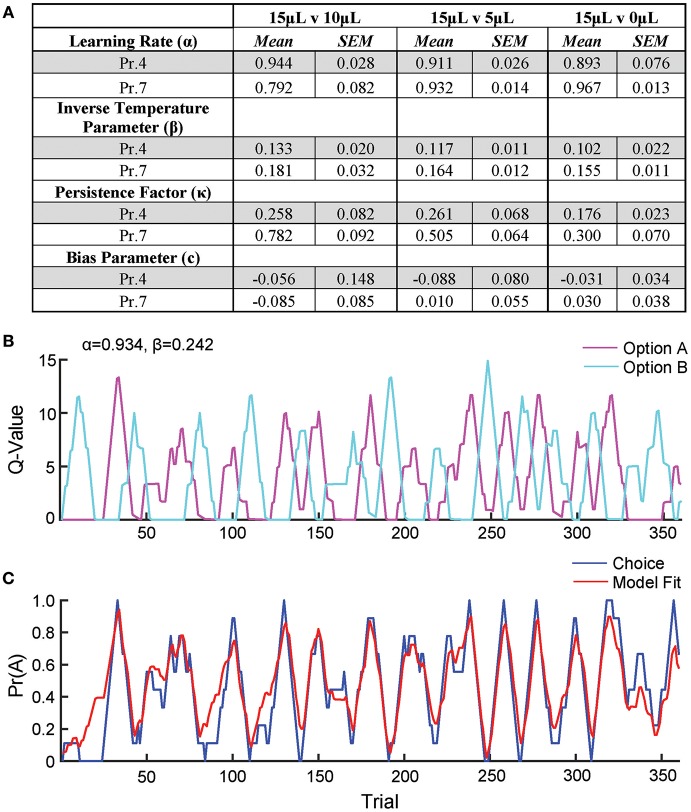
Q-learning reinforcement learning model predicts choice behavior. In order to extract information on how mice update action values using reward prediction errors (α) and how sensitive mouse choice is to differences in action values (β), a reinforcement learning model was fit to the choice data of mice performing the relative reward paradigm. (A) Table summarizing model parameters in both reward probability environments. (B) The calculated Q-values of the two levers for an individual mouse in a single session [15 vs. 0 μL at Prew = 0.7]. As the animal performs reversals, we note an oscillation in the action value for both options. (C) The probability that the mouse selected alternative A on a given trial vs. predicted probabilities generated by the full model. This model is a significant predictor of choice behavior (R2 = 0.43). Q-values and choice probabilities are calculated as a moving average of nine trials.